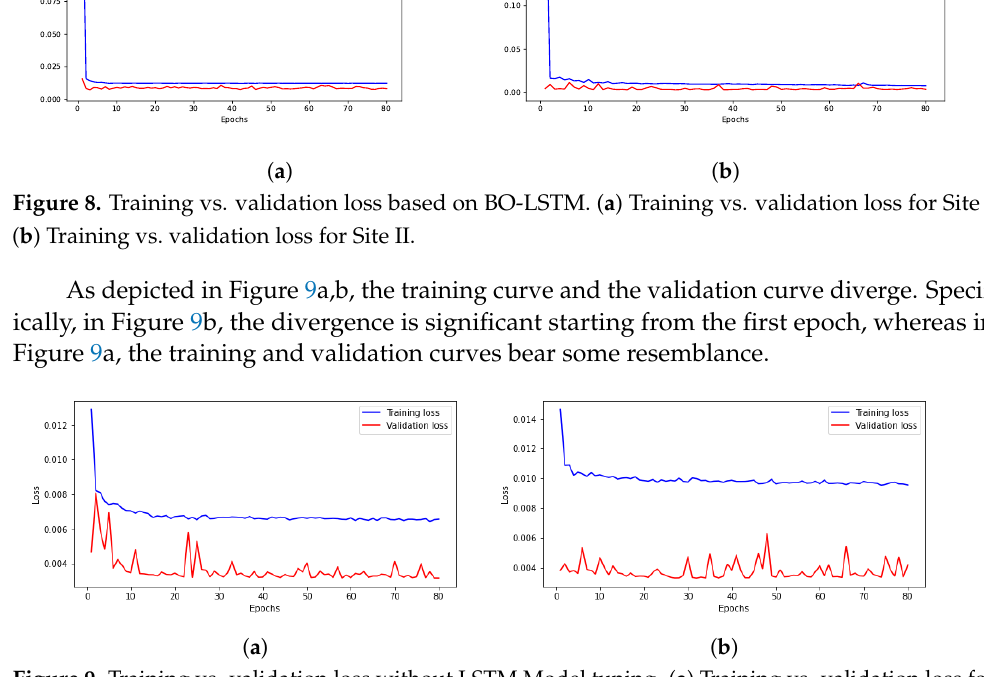
Figure 9. Training vs. validation loss without LSTM Model tuning. ( a ) Training vs. validation loss for Site I. ( b ) Training vs. validation loss for Site